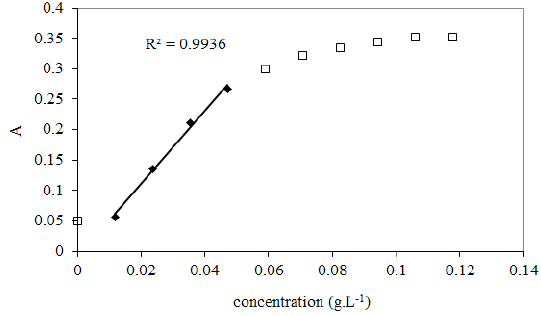
Figure 5. Calibration curve for Novanik 1047 A (no humic substances).